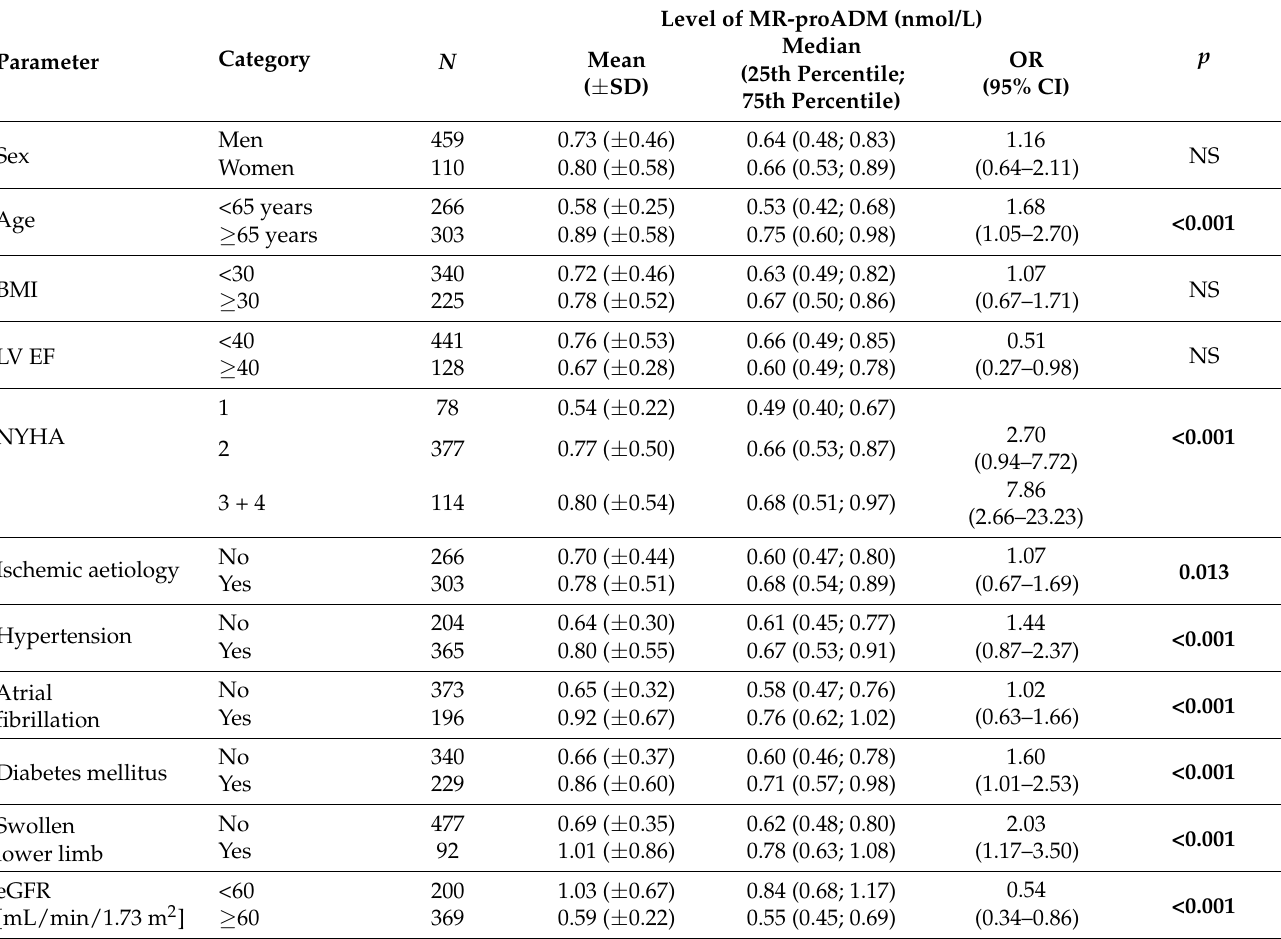
Table 2. Levels of MR-proADM.